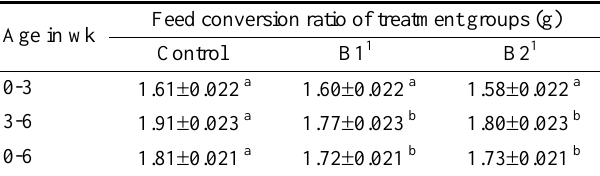
1 B1 = 1 ml Bacillus licheniformis supplemented treatment; B2 = 2 ml Bacillus licheniformis supplemented